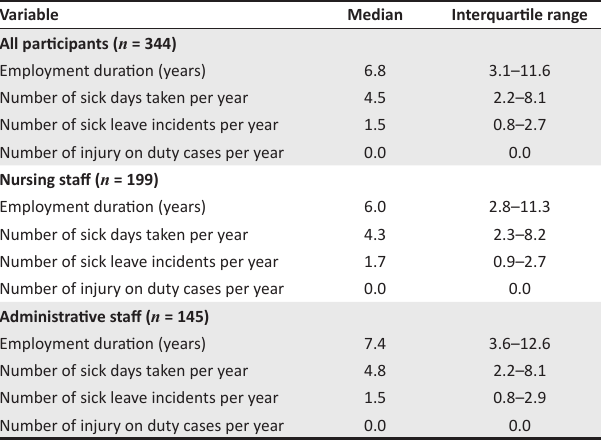
Table 3 indicates the changes of the BMI status of participants